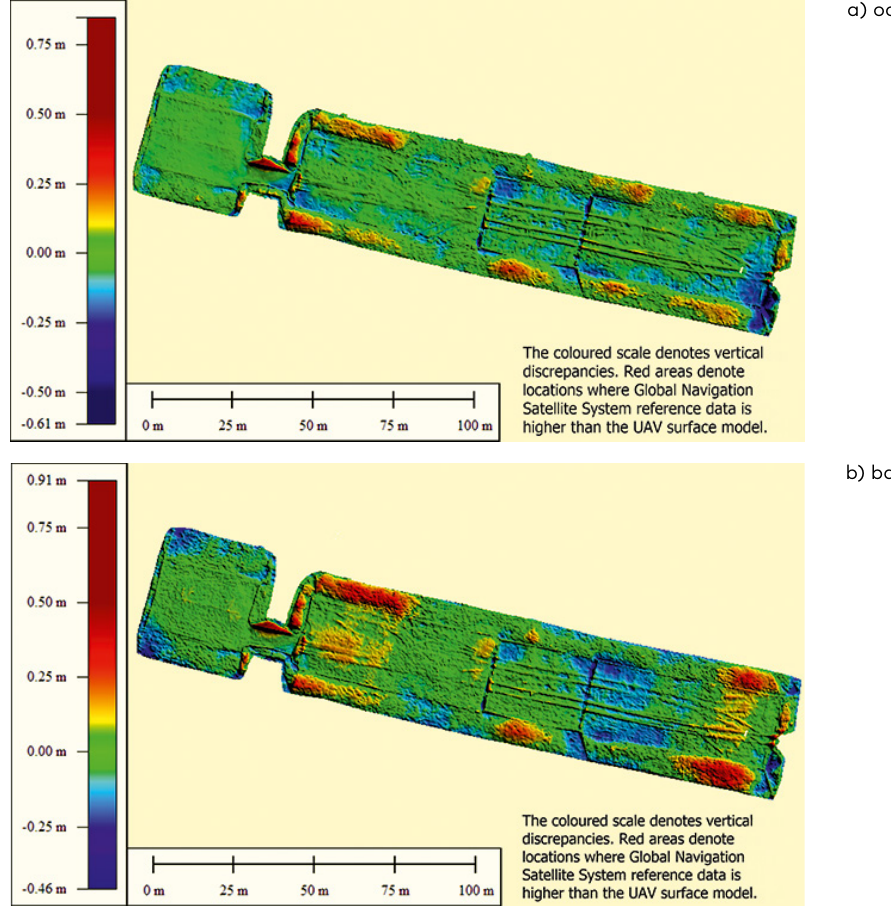
Note: flight height of 60 Figure 5. Comparisons of unmanned aerial vehicle surface models and Global Navigation Satellite System reference data